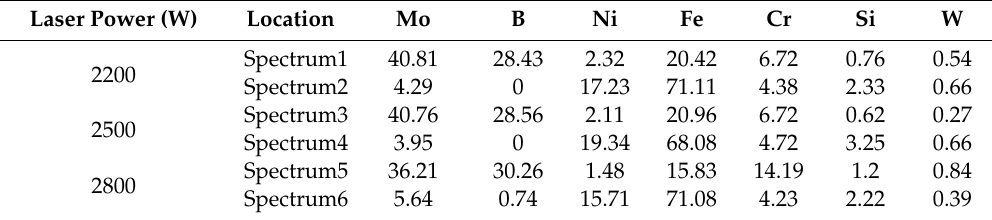
Figure 7. Energy-dispersive X-ray spectroscopy (EDS) analysis of the white and gray phases in the cermet coatings at various laser powers. Table 2. Element contents (at%) at different locations from EDS.